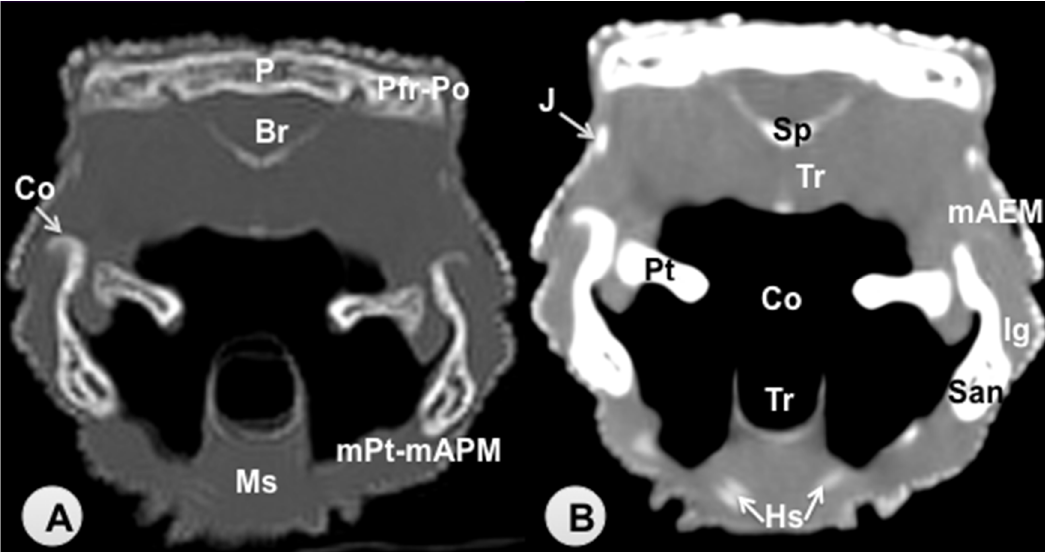
Figure 4. Transverse CT image of the head of Varanus komodoensis at the level of the parietal bone corresponding to line IV. ( A ) CT bone window. ( B ) CT soft tissue window. These images are displayed so that the right side of the head is to the viewer’s left and the dorsal view is at the top. P: Parietal bone (frontoparietal suture). Pfr-Po: Postfrontal + Postorbital bone. Br: Brain. Sp: Sphenoid bone. Pt: Pterygoid bone. San: Surangular bone. Co: Coronoid bone. Co: Cavum oris. Tr: Trachea. Hs: Hyobranchial skeleton. Ms: Musculus intermandibularis + Musculus geniohyoideus + Musculus hyoglossus. J: Jugal bone. Ig: Infralabial glands. mAEM: Musculus adductor mandibulae externus. mPt-mAPM: Musculus pterygoideus + Musculus adductor mandibularis posterior.